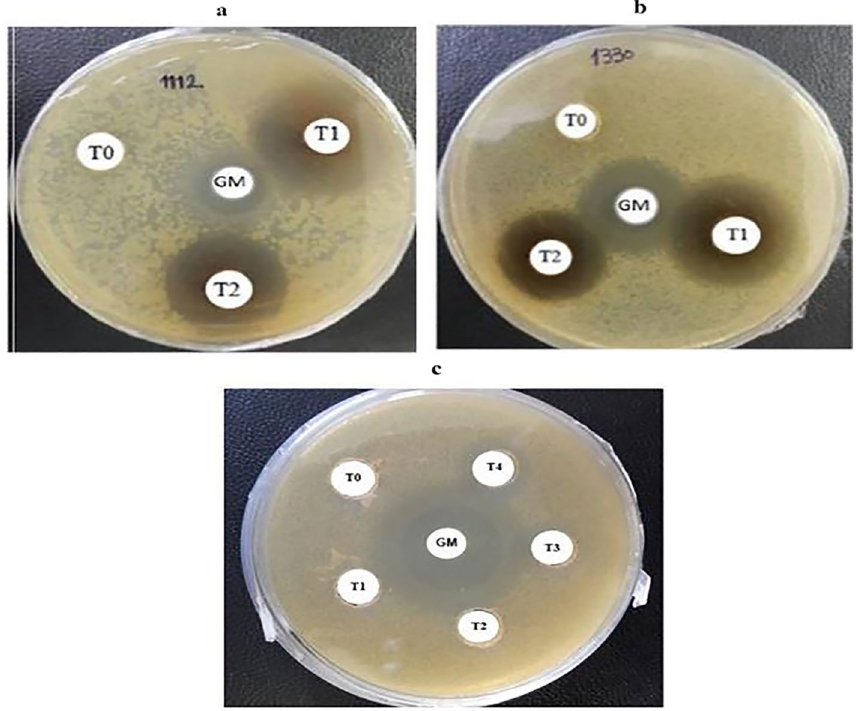
Figure 5. The anti-microbial and anti-fungal activities of rMAP30-KDEL . The anti-microbial activities of MAP30 extracted from the transgenic hairy root lines were assessed by S. aureus 1112 ( a ) and E. coli 1330 ( b ) through disc diffusion assay for 16 h (Table 5). GM, T0, T1 and T2 respectively indicate gentamycin (10 μg/ disc), 75 μg of transgenic total protein (control), the transgenic total protein (55 μg), and the rMAP30 (10 μg).